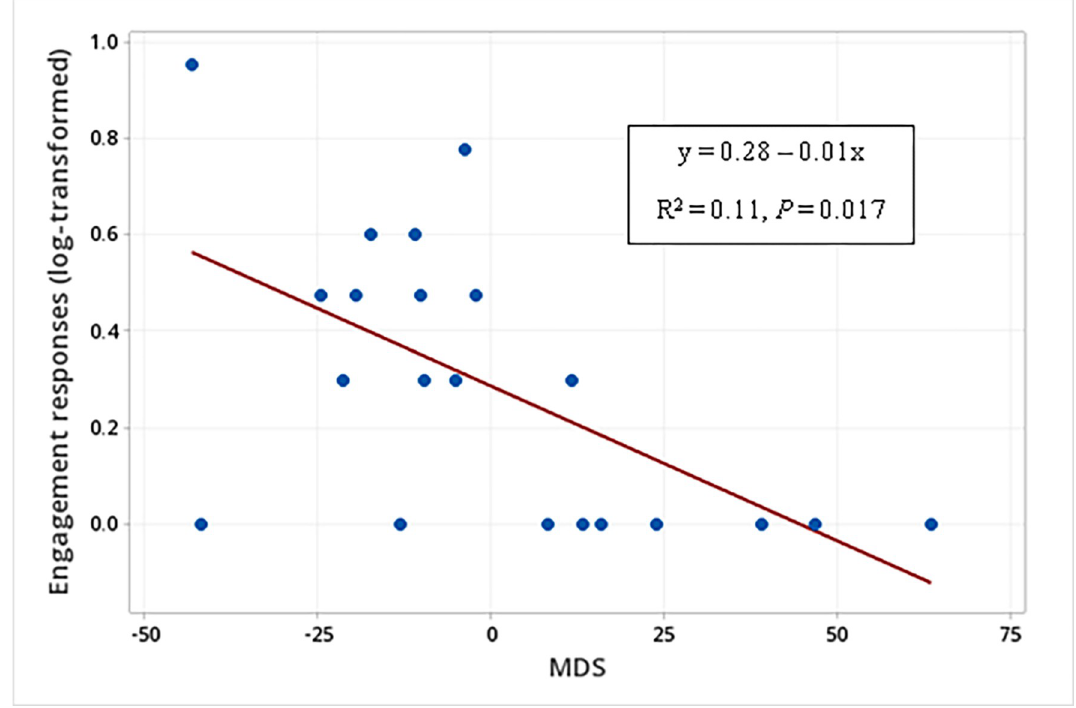
Fig 12. Relationship between the sender’s social rank (MDS) and the occurrence of engagement responses (log-transformed). Occurrence of engagement responses to unimodal and multimodal signals produced when white-lipped peccaries (N = 21) were displaying submission behaviors.